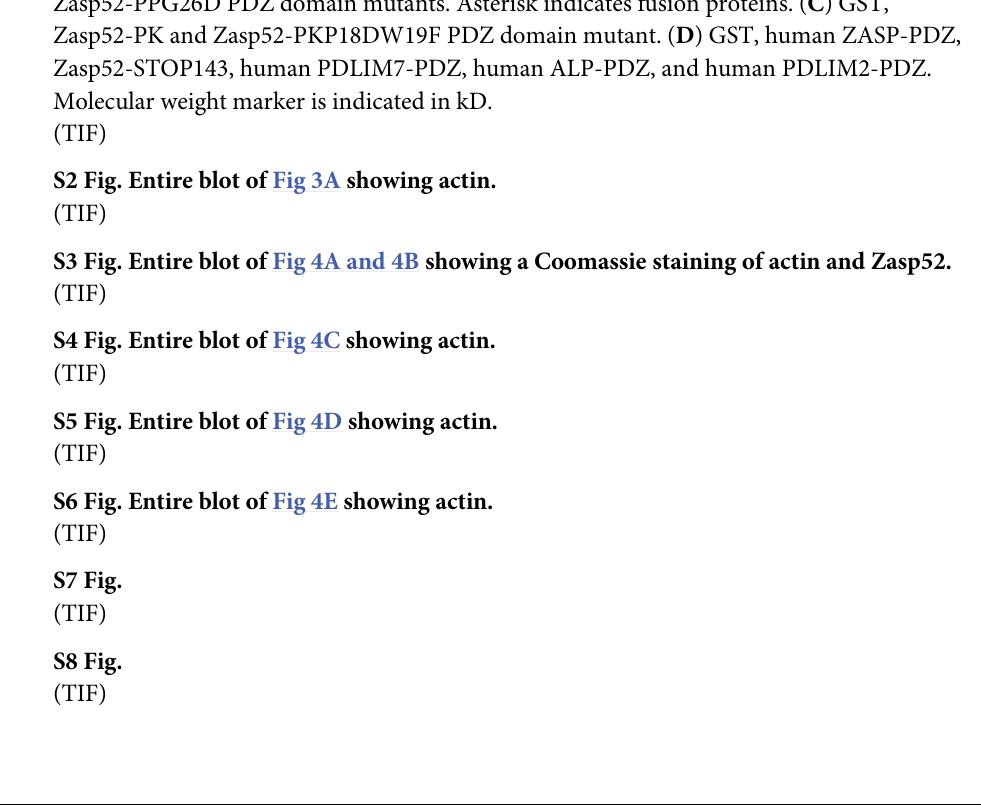
S1 Fig. Purification of GST-Zasp52 fusion proteins. Coomassie staining of Zasp52 domain GST fusions run on a SDS-PAGE gel after purification. ( A ) GST, Zasp52-PK and Zasp52- LIM234. Asterisks indicate fusion proteins. ( B ) GST, Zasp52-PP, Zasp52-PPG25W, and